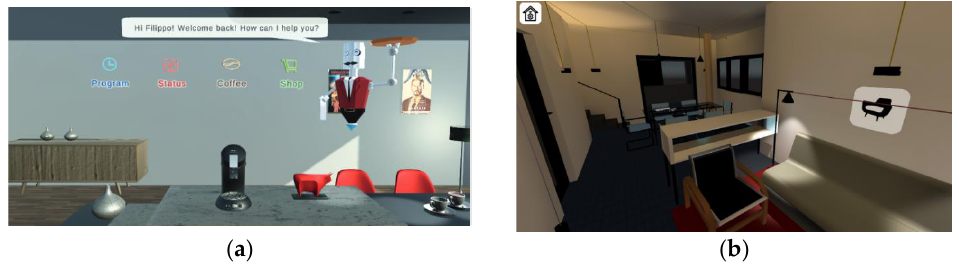
Figure 8. ( a ) Espresso coffee machine GUI; ( b ) domotic lighting control